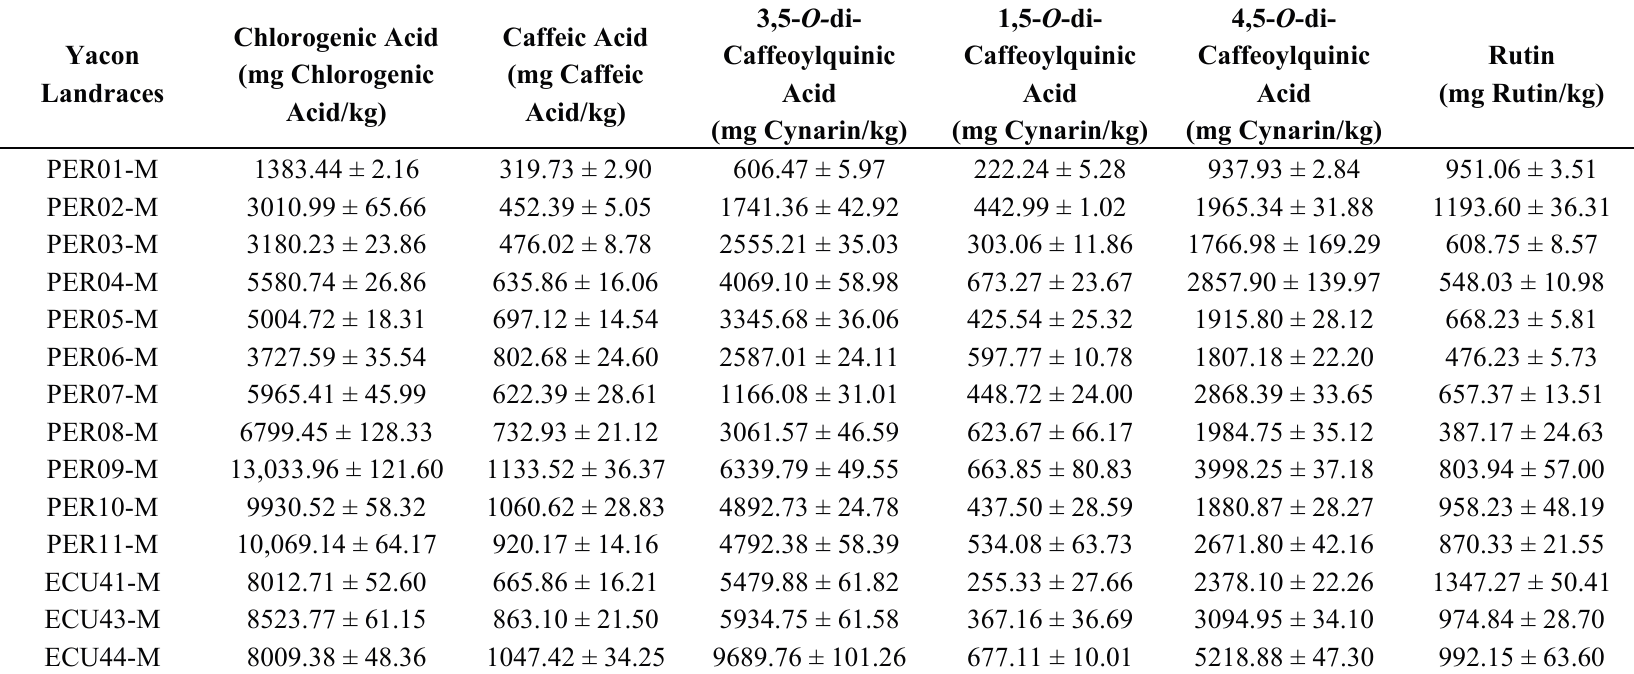
Table 2. HPLC quantification of identified compounds in yacon